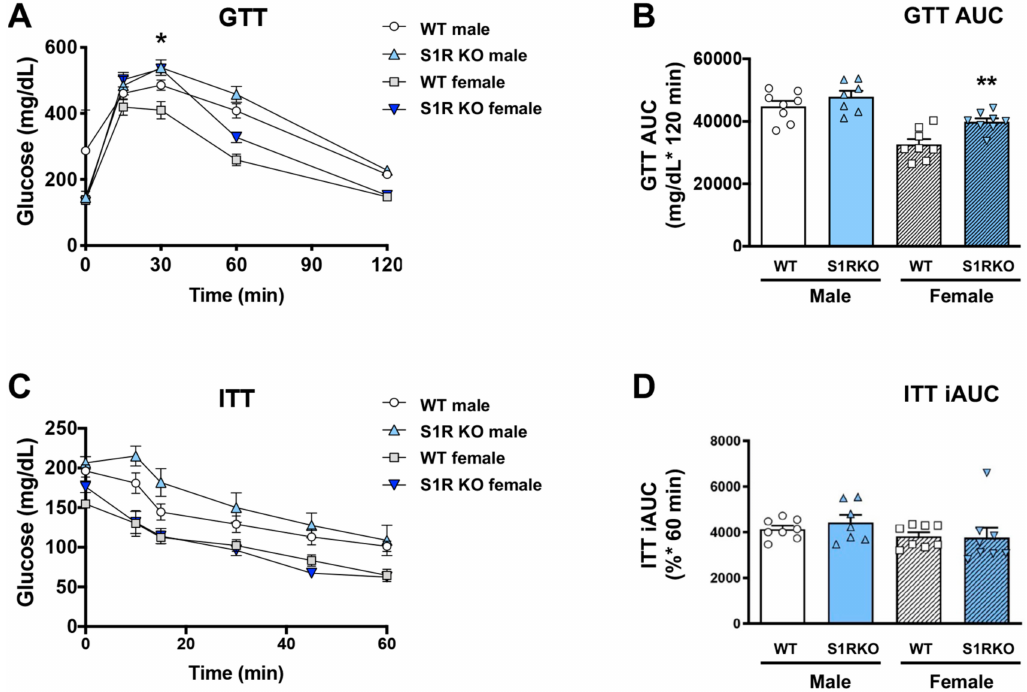
Figure 3. S1R ablation impairs glucose tolerance in female mice fed on HFD. GTT and ITT